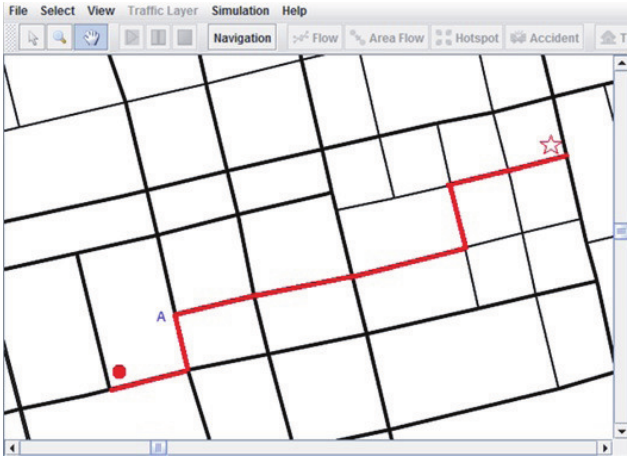
Figure 11. Path search result under normal situation.